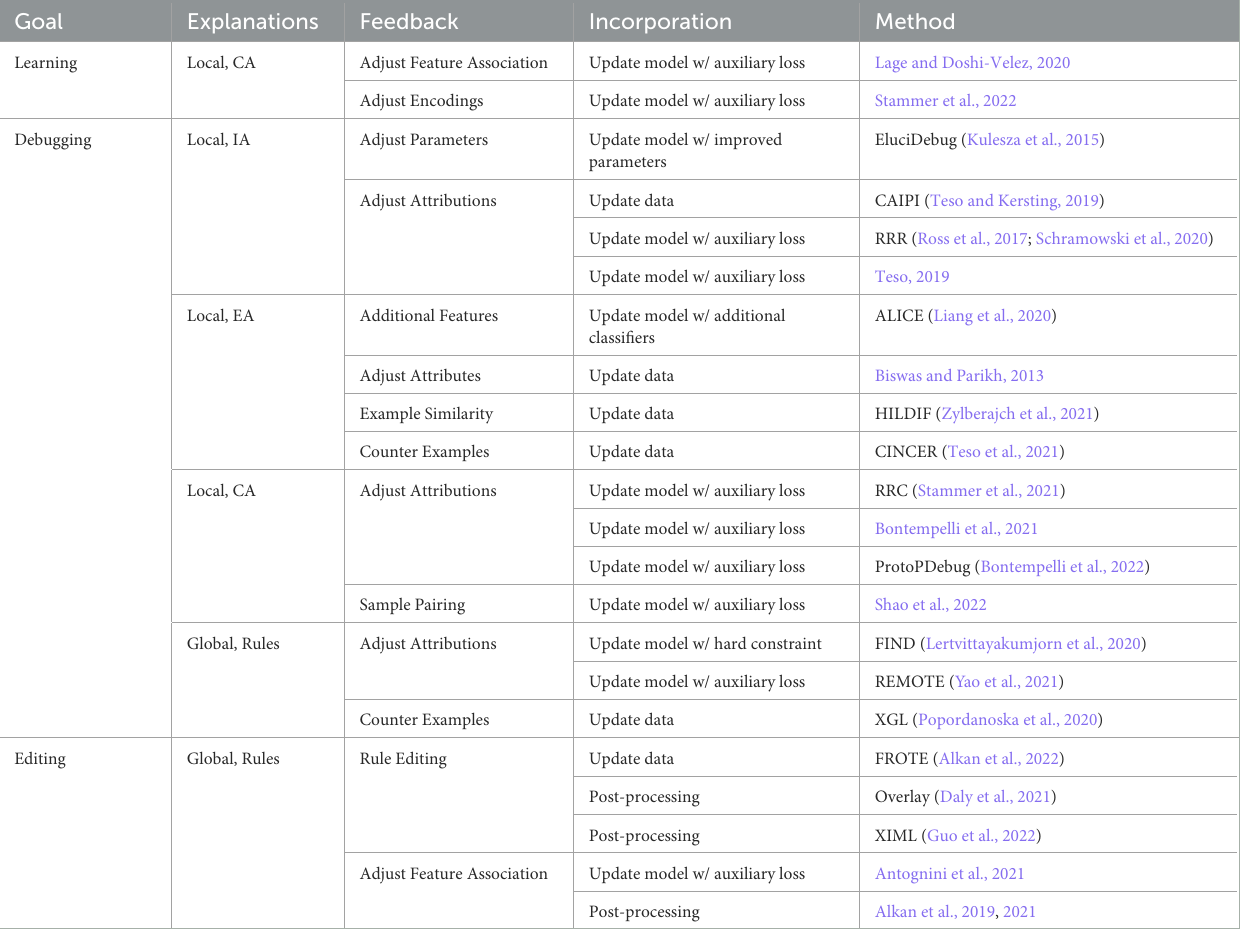
TABLE 1 Table of methods covered in this